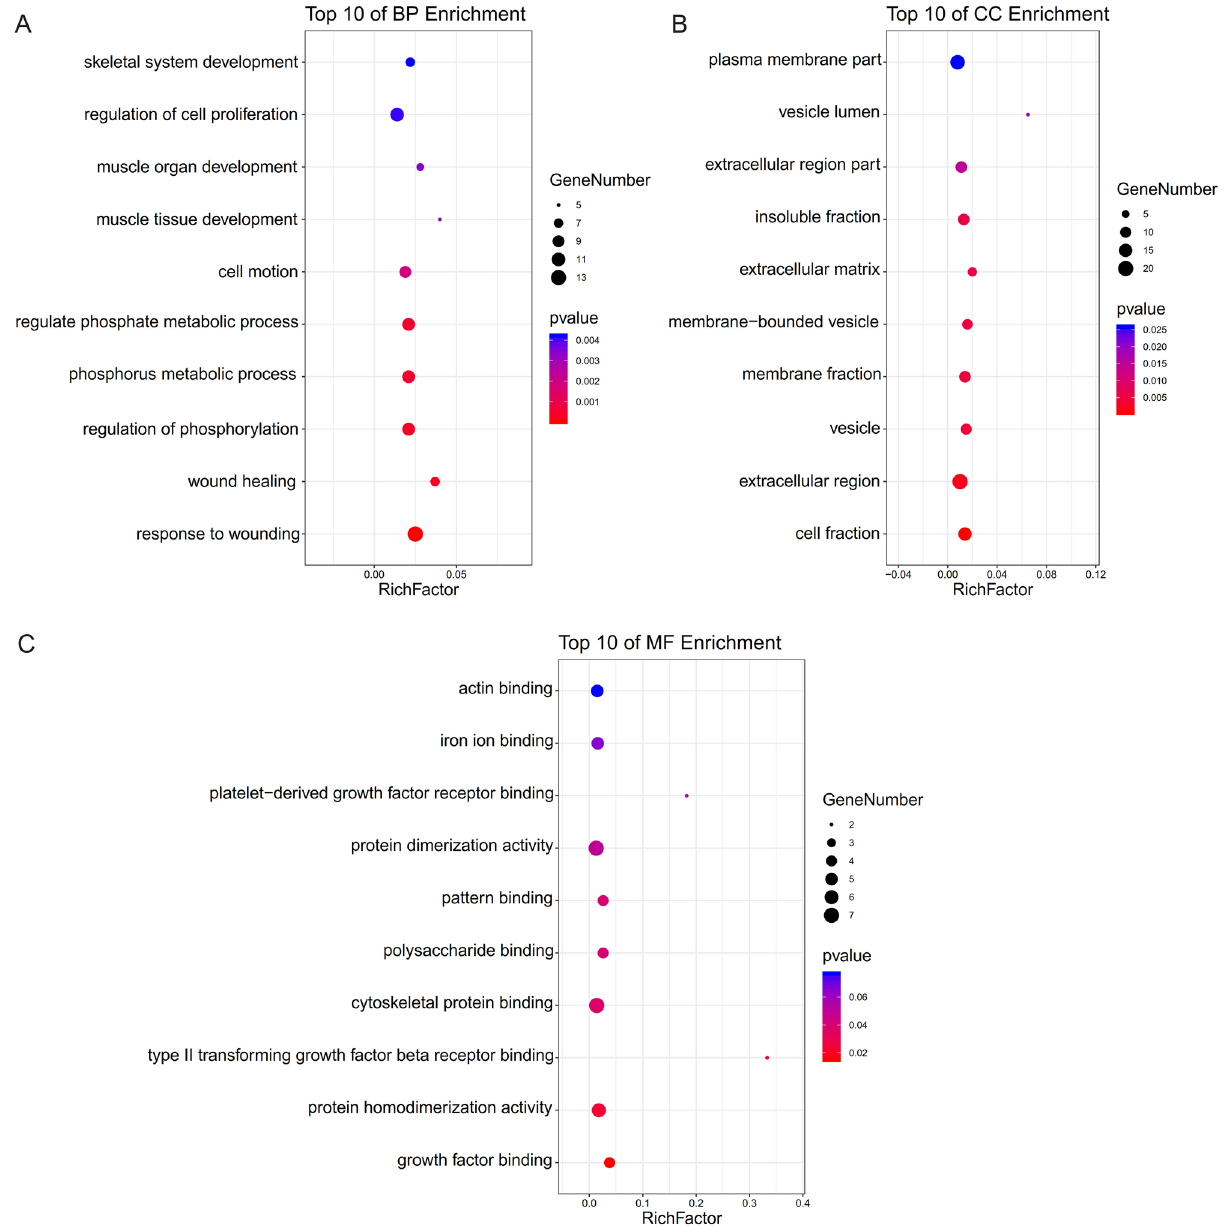
Figure 3. The functional annotation for the DEGs based on the DAVID. ( A ) BP, ( B ) CC, ( C )